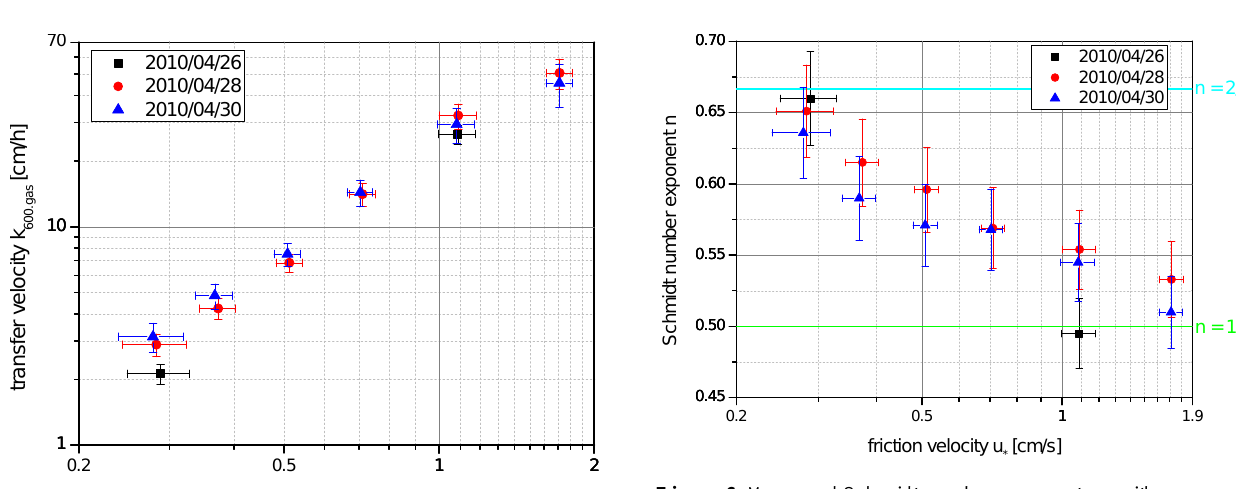
Figure 6. Measured Schmidt number exponents n with an error of 5% plotted against the global averaged friction velocity u ∗ . Dates are given in YYYY/MM/DD.